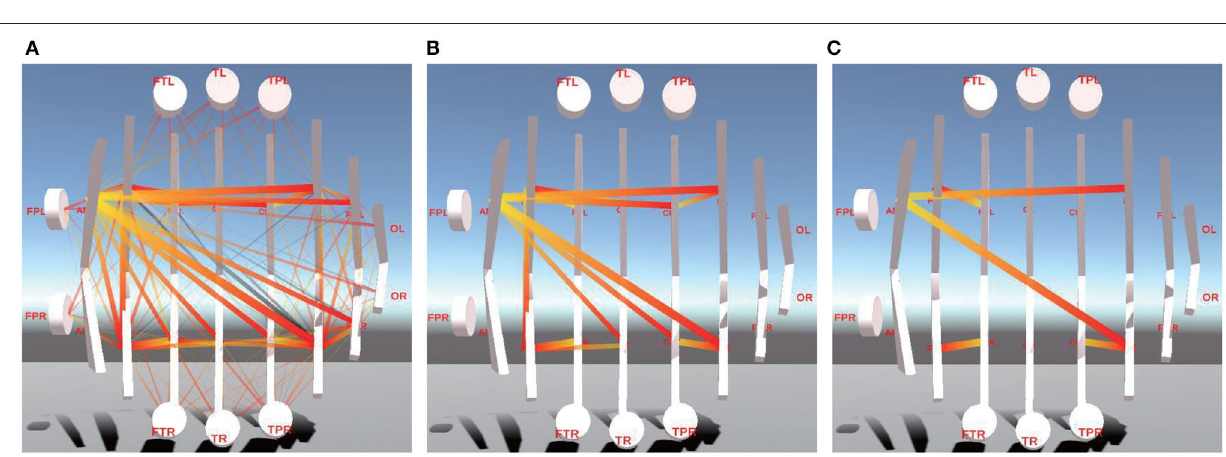
channels in the frontal lobe(F region), the frontal cortex(FC region), and the frontal temporal lobe(FT region) is commonly stronger than in other